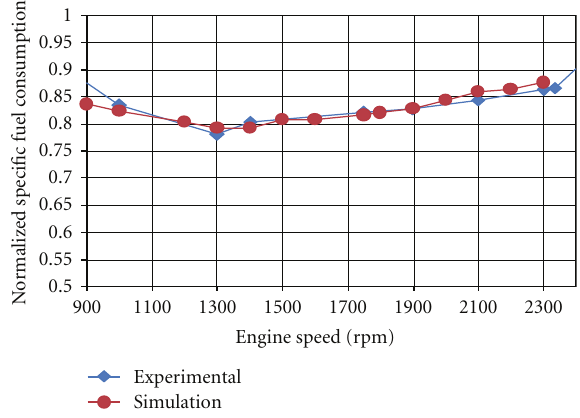
Figure 3: Comparisonof experimental and simulated values of heat release rate (2300rpm; 100% load).